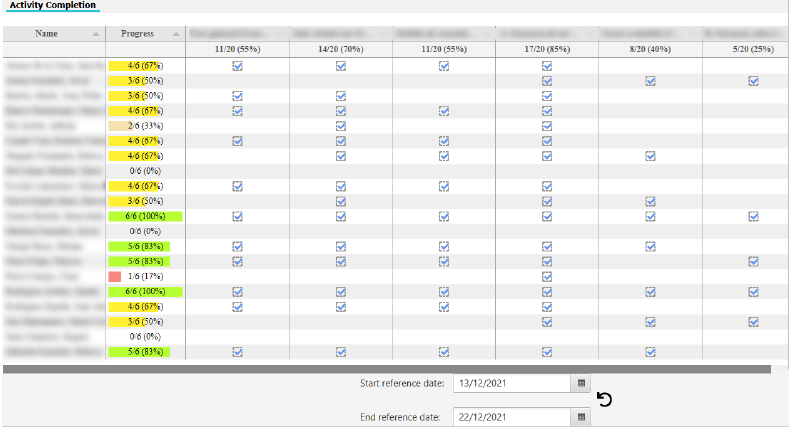
Figure 6. Configurable activity completion table with a time